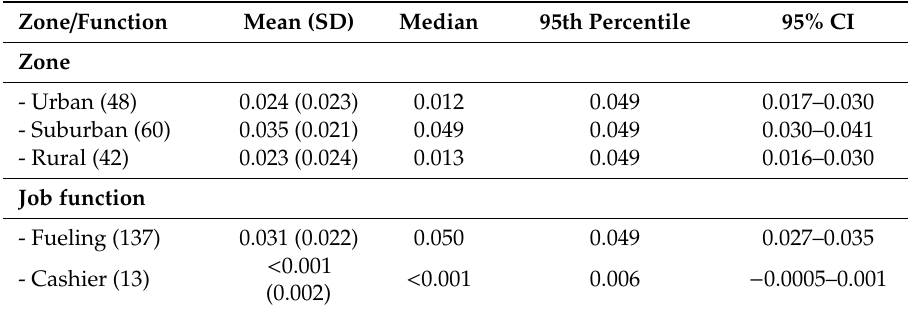
Table 1. Concentration of benzene classified by zones and functions of gasoline station workers